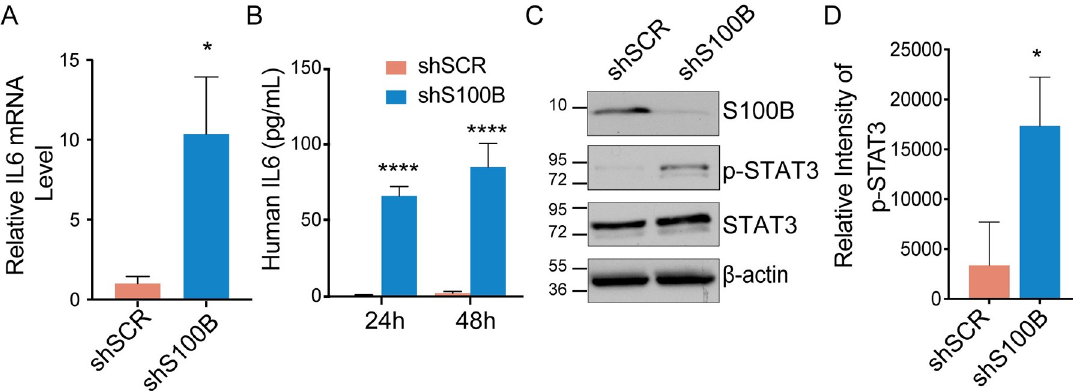
Fig 1. Knockdown of S100B in WM115 malignant melanoma cells increases IL6 expression and STAT3 phosphorylation. (A) qRT-PCR analysis was done to compare the IL6 mRNA levels in non-targeting scrambled and stable S100B knockdown WM115 cell lines, respectively and (B) an IL6 ELISA was used to detect secreted IL6 levels 24 and 48 hours after the introduction of new media. Both IL6 mRNA and secreted protein levels increase significantly upon knockdown of S100B (n = 4, mean ± SD; � , P < 0.05; ���� , P < 0.0001). (C) Immunoblot analysis of shS100B WM115 cells shows little or no detectable S100B protein compared to shSCR WM115. In addition, levels of total STAT3 remain constant while there is a significant increase in p-STAT3 (Tyr705) in shS100B versus shSCR WM115 as shown by the average densitometry measurements of the p-STAT3 (D) (n = 3, mean ± SD; � , P < 0.05).